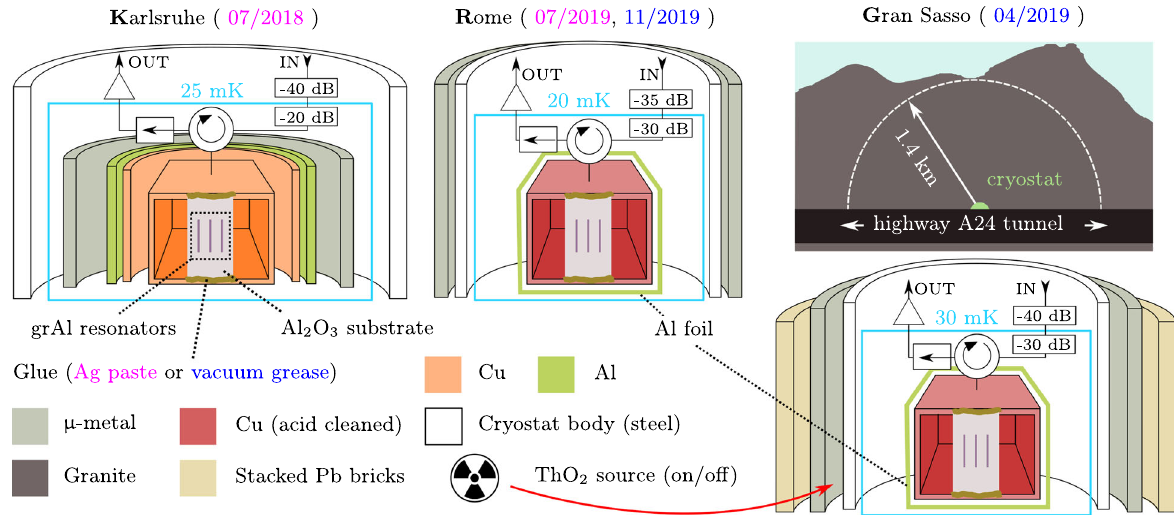
Fig. 2 Three different setups with various degrees of shielding against ionizing radiation. Schematic half-sections of the setups, in Karlsruhe, Rome, and Gran Sasso, denoted K , R , and G , respectively. The measurement dates for each setup are indicated in the top labels. The sapphire chip is glued to a copper waveguide using either silver paste (K and R, magenta) or vacuum grease (G and R, blue). A circulator routes the attenuated input signal to the sample holder, and the re fl ected output signal to an isolator and an ampli fi cation chain (cf. Supplementary Information). In the R and G setups, the waveguide is etched with citric acid to remove possibly radioactive contaminants. The G setup, located under 1.4 km of granite (3.6 km water equivalent) is operated in three con fi gurations. First, the cryostat is surrounded by a 10 cm thick wall of lead bricks. Two days later, the bricks were removed. Finally, we added a ThO 2 radioactive source next to the cryostat body (cf. red